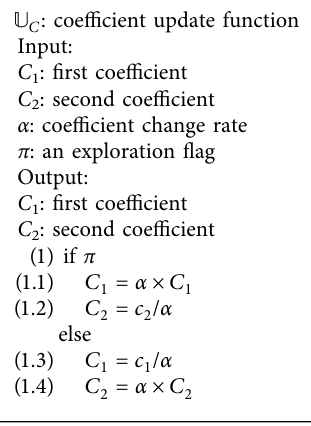
Table 1: Summary of test functions in the CEC 2009